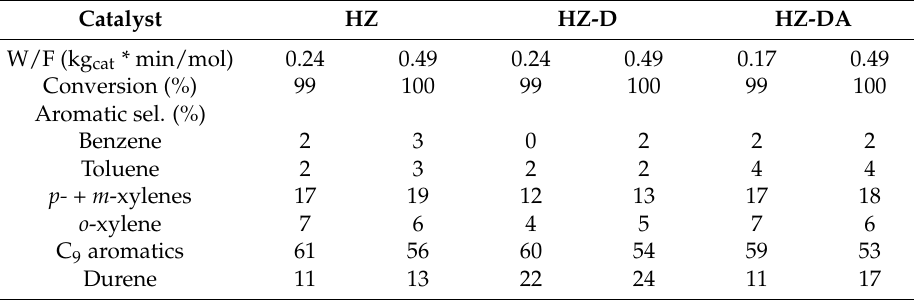
Table 4. Initial aromatic selectivity at 400 ◦ C with different contact